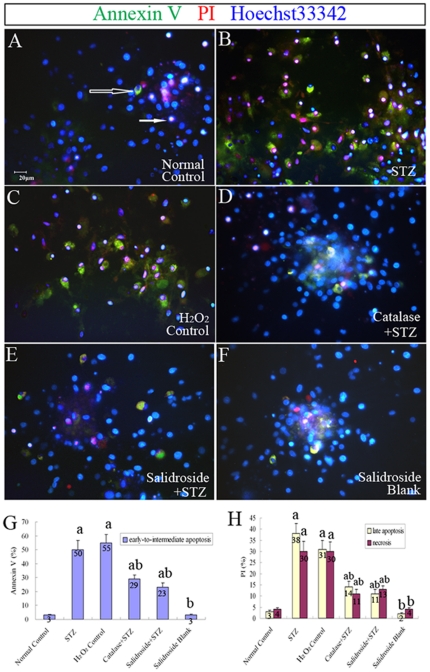
Annexin V and PI immunolabeling for detection of apoptosis and necrosis in NSCs, respectively.(A–F) Representative fluorescence photomicrographs of NSCs immunoreactive to annexin V (green) and PI (red) with their nucleus counterstained with Hoechst33342 (blue) in six experimental groups: (A) Normal control group; (B) STZ group; (C) H2O2 control group; (D) Catalase+STZ group; (E) Salidroside+STZ group; (F) Salidroside blank group. Cell at early to intermediate stages of apoptosis are positive to Annexin V but negative to PI (open arrow); late apoptosis cells are PI positive with chromatin condensation; and necrotic cells are PI positive without chromatin condensation (solid arrow). (G) Bar chart showing the percentages of annexin V-positive cells which are at the early-to-intermediate stage of apoptosis. (H) Bar chart showing the percentages of PI-positive cells, indicating that they are either late apoptotic or necrotic cells. Values are expressed as mean±SD. Numbers within bars represent the actual numerical reading on the y-axis. a
p<0.05 compared with the normal control group; b
p<0.05 compared with the STZ group.